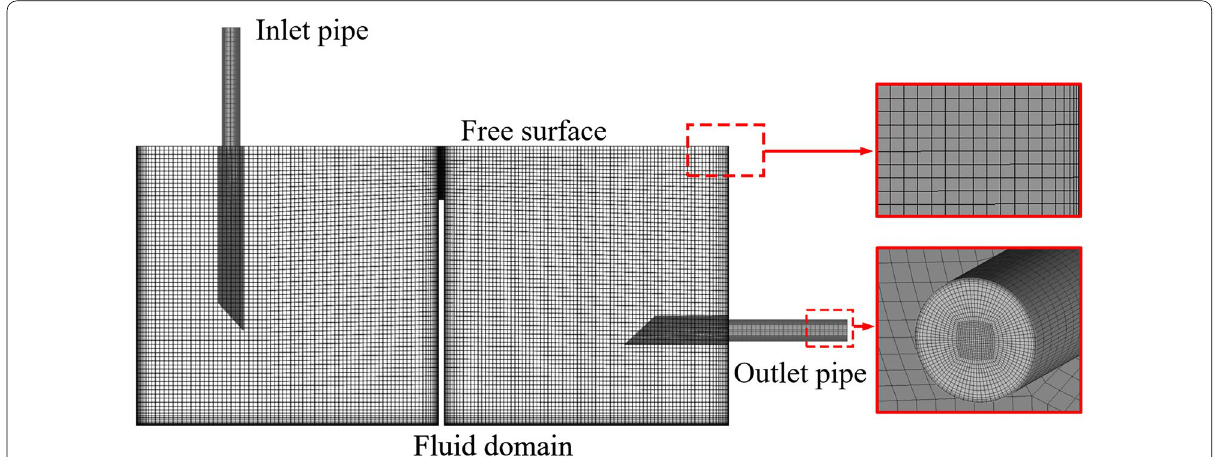
Figure 6 Reservoir fluid domain and its mesh details